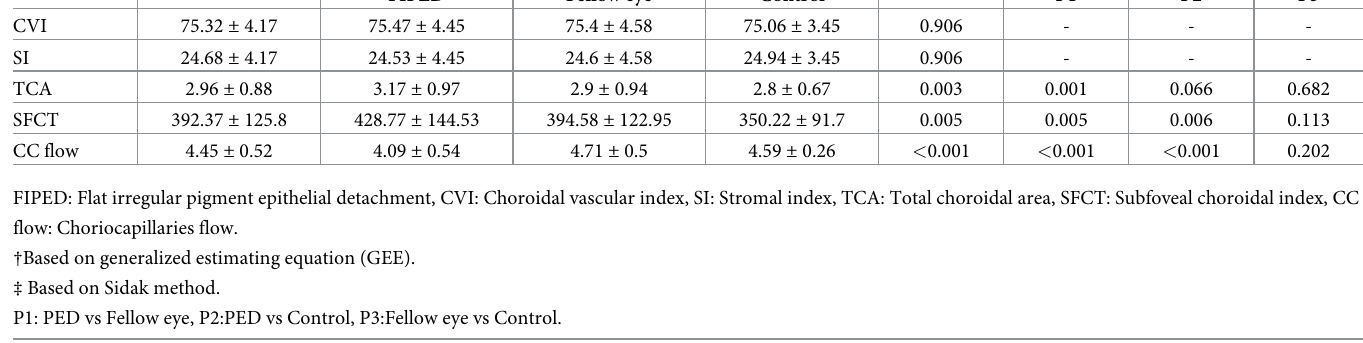
Table 4. Comparison between avascular and vascularized FIPEDs in chronic CSC. Quantitative Multivariate analysis variable